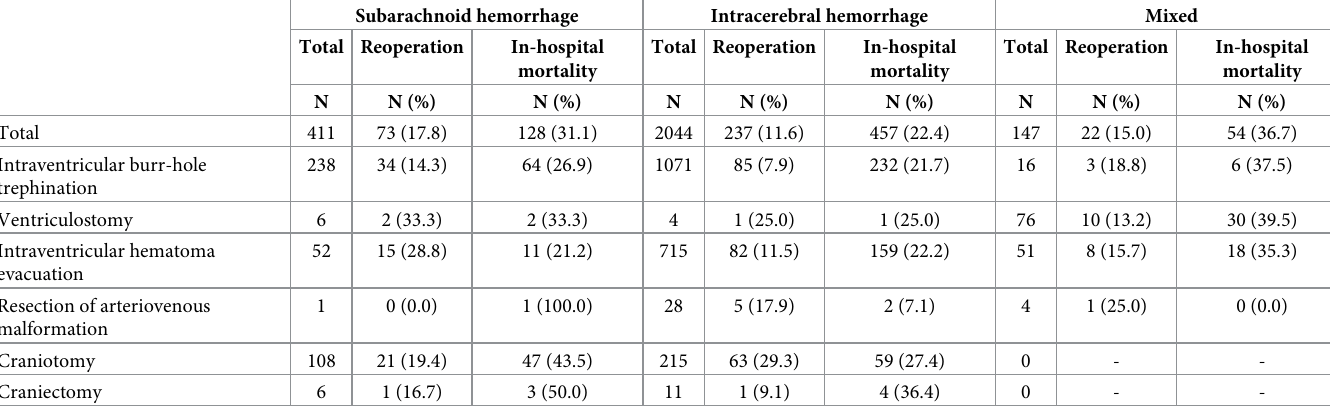
Table 3. Emergency neurosurgery by subtype of spontaneous hemorrhagic stroke.